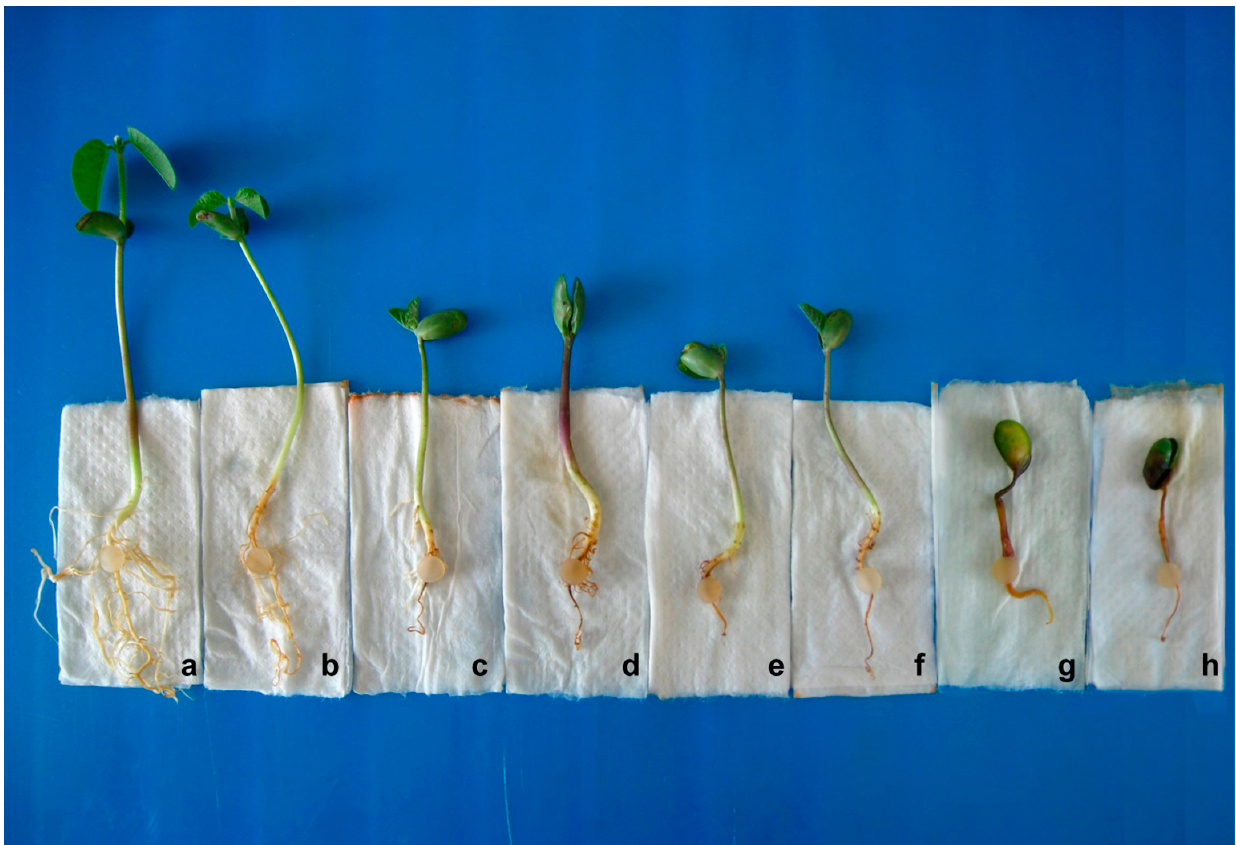
Figure 3. The reaction of roots after inoculation with P. sojae strain using radicle inoculation method. a—No visible disease symptoms on taproot and lateral roots (denoted as 0); b—Trace of rot on taproot and lateral roots (denoted as 1); c—Less than the bottom third of taproot mass rotted (denoted as 2); d—Bottom third of taproot mass rotted (denoted as 3); e—Bottom two-thirds of taproot mass rotted (denoted as 4); f—More than the bottom two-thirds of taproot mass rotted (denoted as 5); g—Taproot completely rotted with only a few lateral roots (denoted as 6); h—Taproot completely rotted without lateral roots + plant death (denoted as 7).